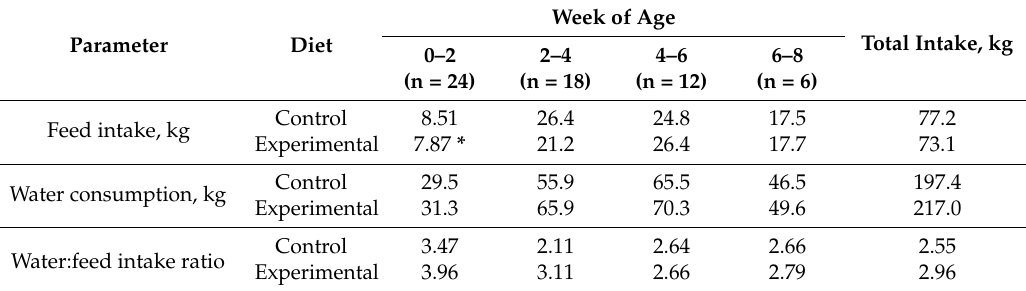
Table 2. Intake of feed and consumption of water (kg) of birds during the trial.